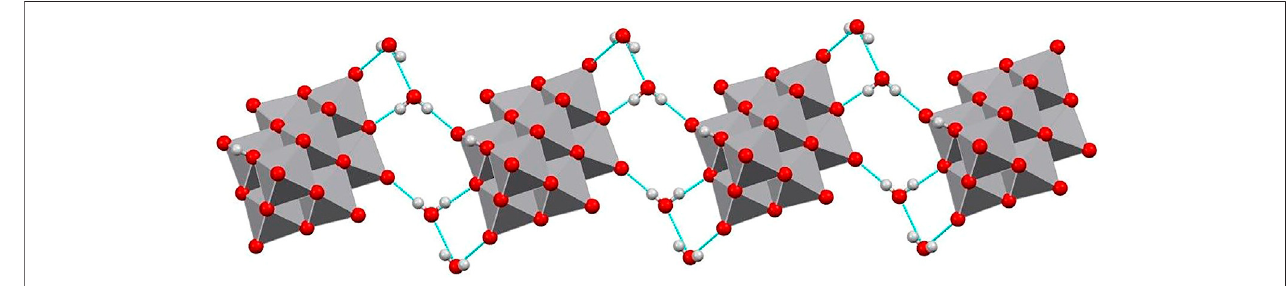
FIGURE 4 | Mercury representation of a chain of decavanadate anions connected through water molecule forming rings R 3 3 (8) and R 4 4 (12).